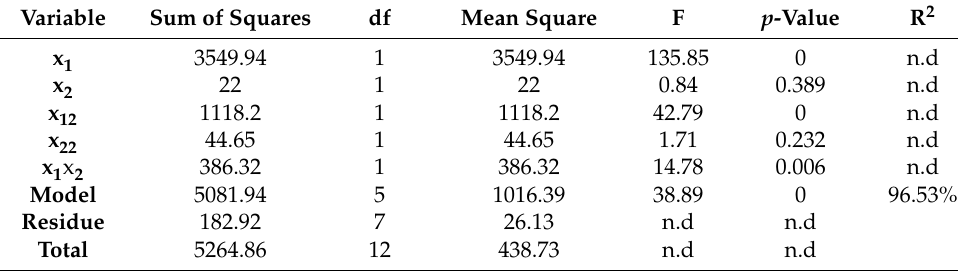
Table 6. ANOVA and regression results for Mg extraction.